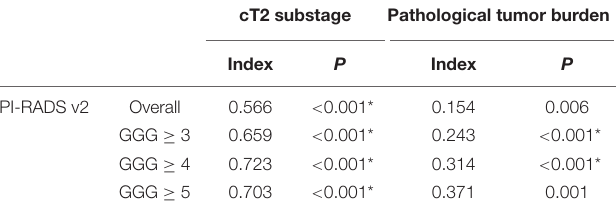
TABLE 5 | Correlation between tumor burden and PI-RADS v2